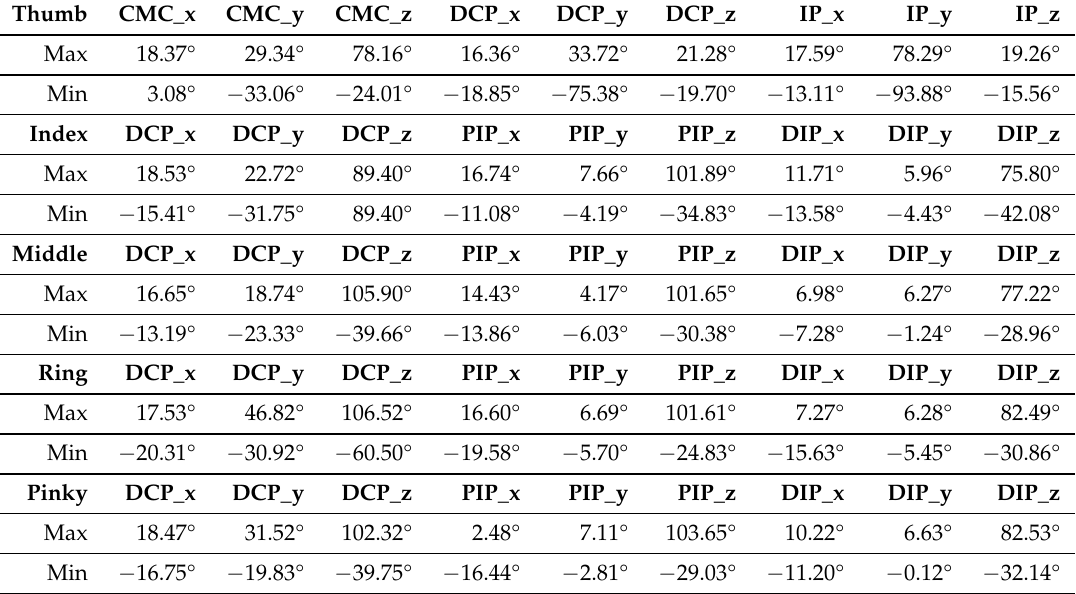
Table 1. The extracted limitations of pose parameters. We extract those limitations by fitting MANO model to the database provided by [44] using our kinematic structure.